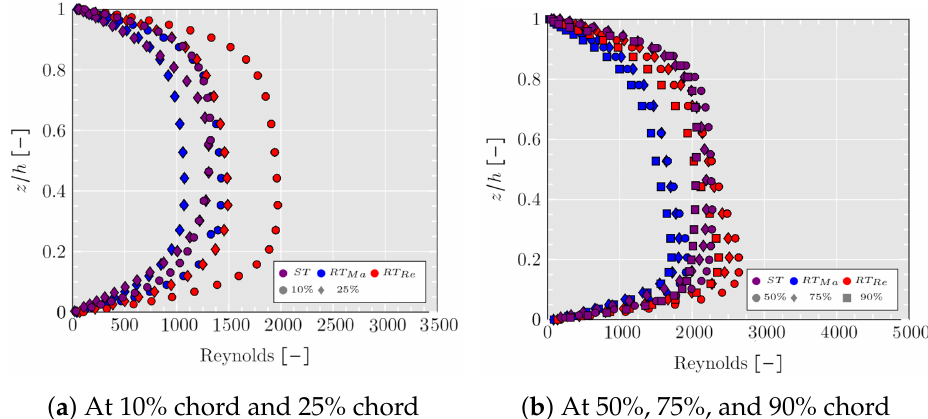
Figure 13. Local Reynolds number distribution in the clearance. ST and RT; VGT30; 0.5 mm tip height. In the figure, legend colors stand for each case, while shapes in gray determine each of the chord positions where data are taken.